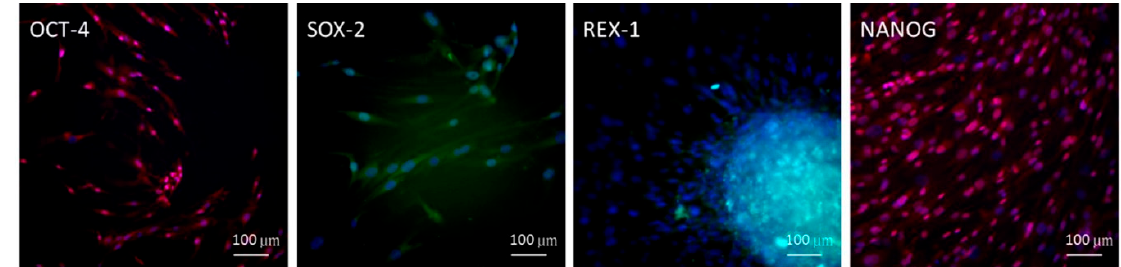
Figure 1. Embryonic stem cell characteristics of adipose-derived stem cells (ADSCs), shown by positive immunofluorescence staining results for OCT-4, SOX-2, REX-1, and NANOG expression (scale bar = 100 μ m).